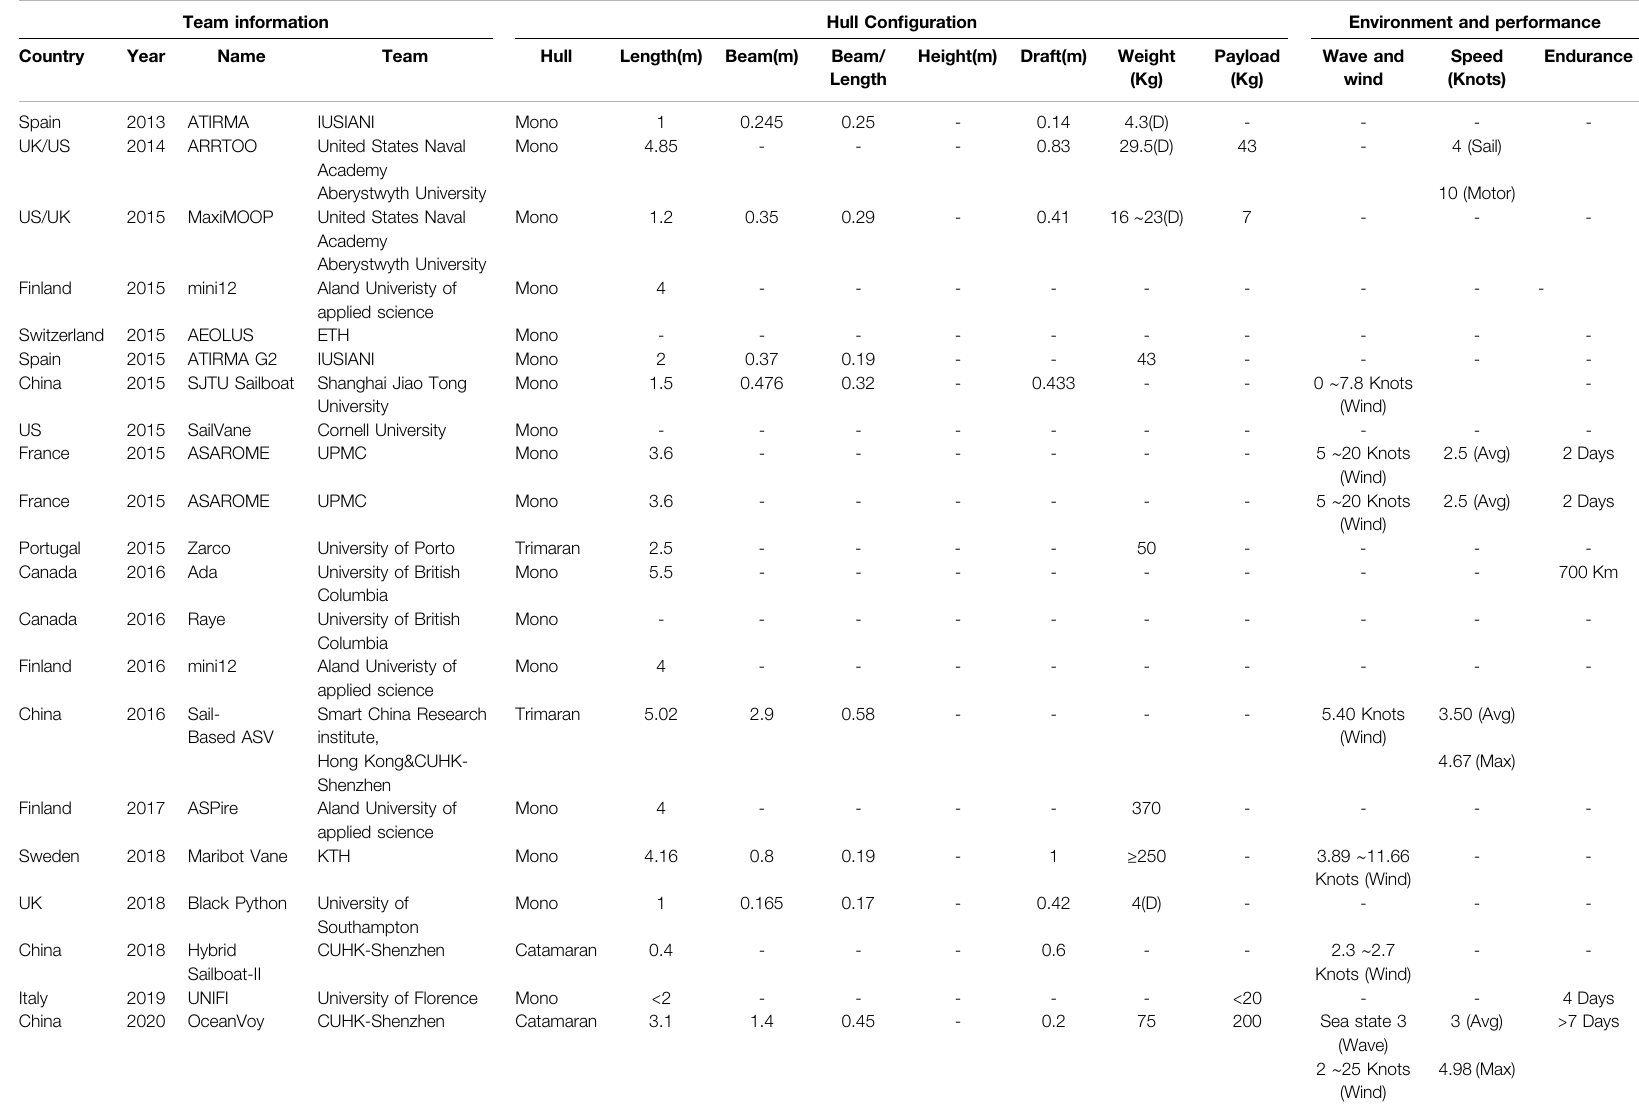
TABLE 1 | ( Continued ) The sailboats con fi guration about team information, hull con fi guration and environment in different research groups. Noted: The column of “ Beam/Length ” represents the ratio between beam and length; In “ Weight (Kg) ” column, If the data ended with “ (D) ” , which is described the data is displacement. Otherwise, the data is the weight of sailing